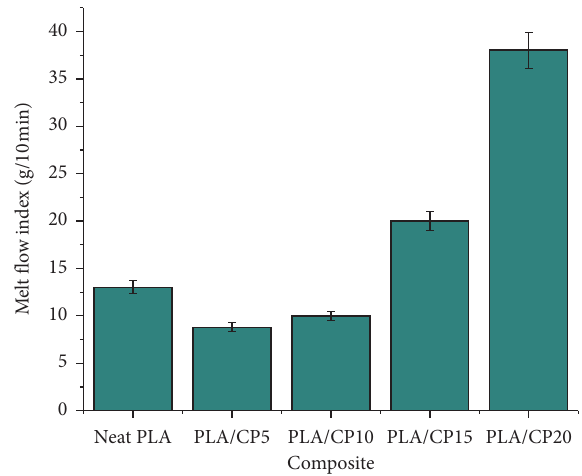
Neat Figure 5: Heat deflection temperature of PLA/CP.